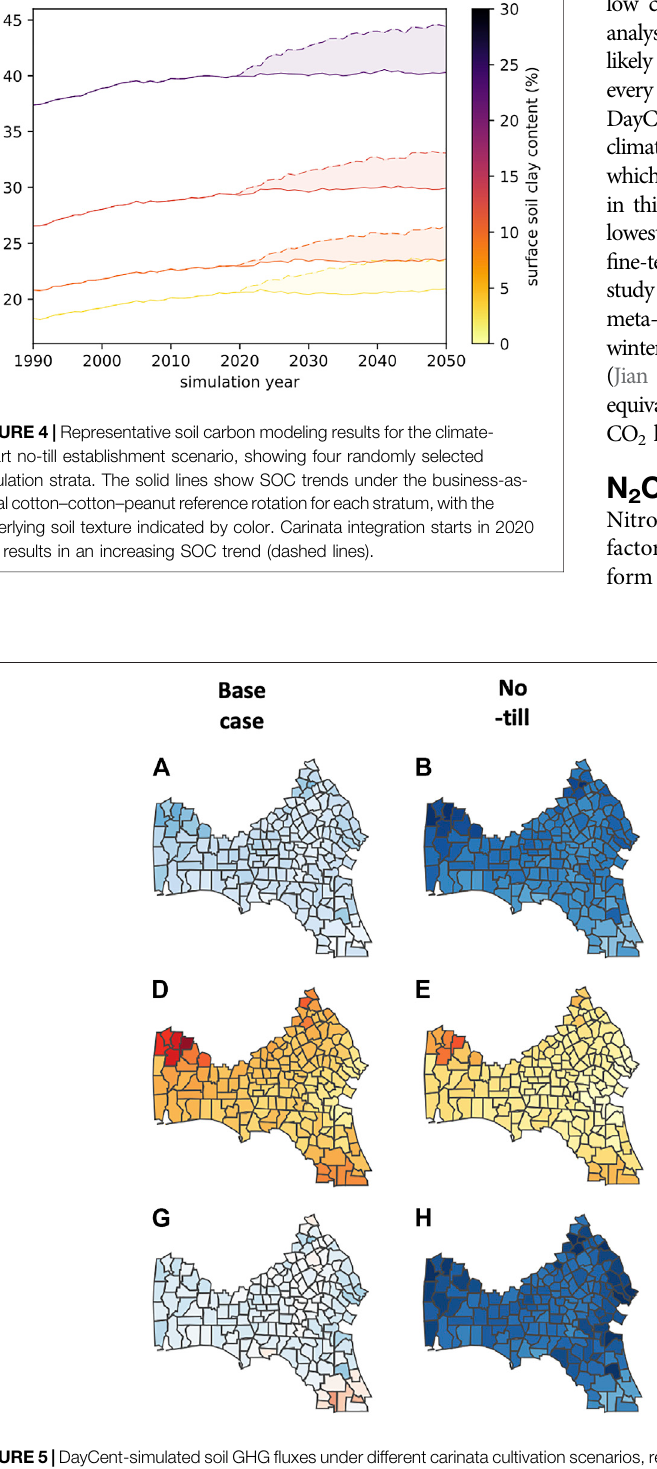
Frontiers in Energy Research |